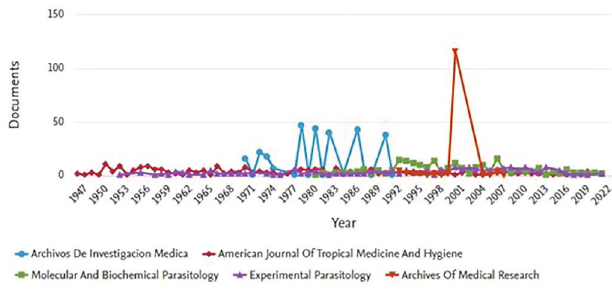
Figure 2 - Comparison of number of the